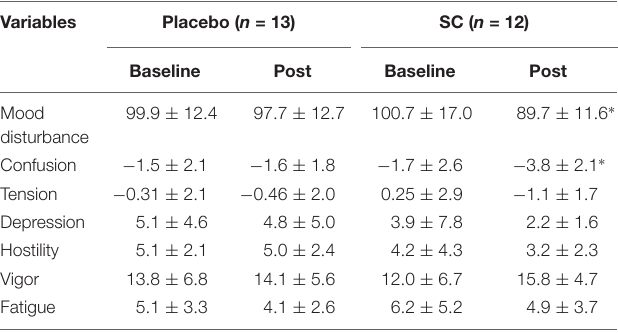
TABLE 4 | Comparison between placebo and supplementation groups on the psychological response.